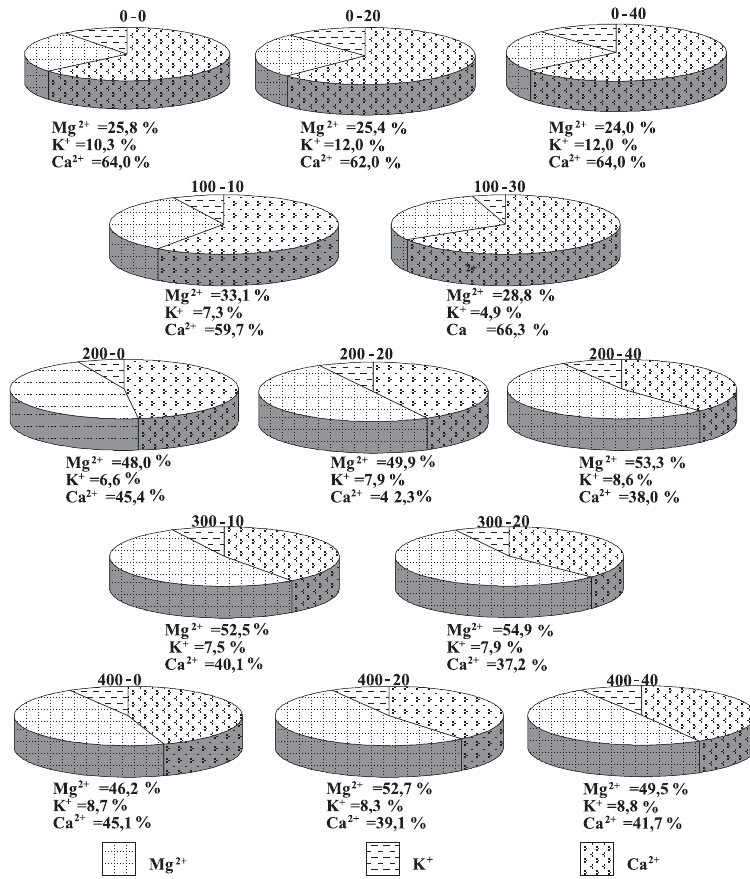
Figura 4. Proporções de K + , Ca 2+ e Mg 2+ no teor total (mmol aérea do capim-marandu, no primeiro corte, em função das 13 combinações de doses de N e de